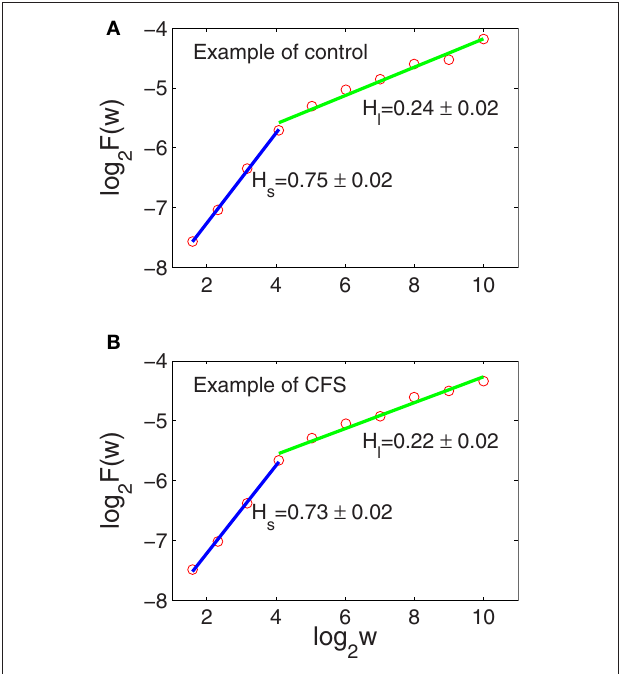
FIGURE 2 | AFA of the IBI data shown in Figures 1A,B. The scaling break around w = 2 4 is generic among all the subjects. (A,B) The red circles are for computed H, the blue lines are a linear fit for H s , and the green lines are linear fits for H l .